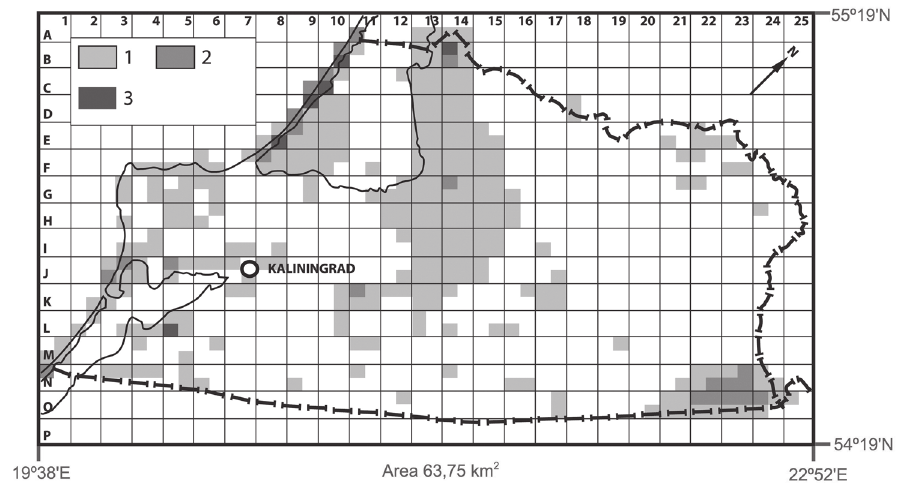
Figure 11. Species saturation (number of species in a square) of the protected plant and animal species in the territory of Kaliningrad region. 1 1-3 species per square; 2 4-6 species per square; 3 7-9 species per